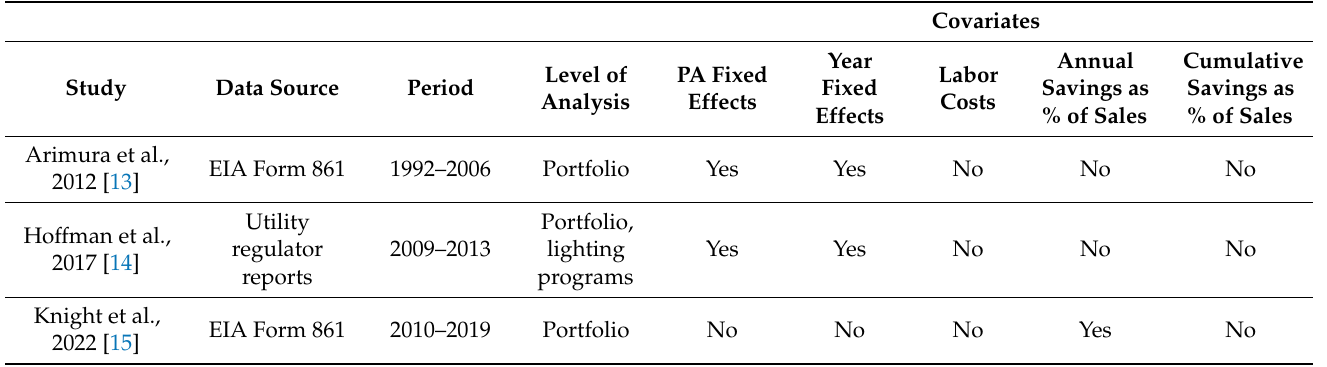
Table 1. Comparison of econometric models of the cost of saved electricity.